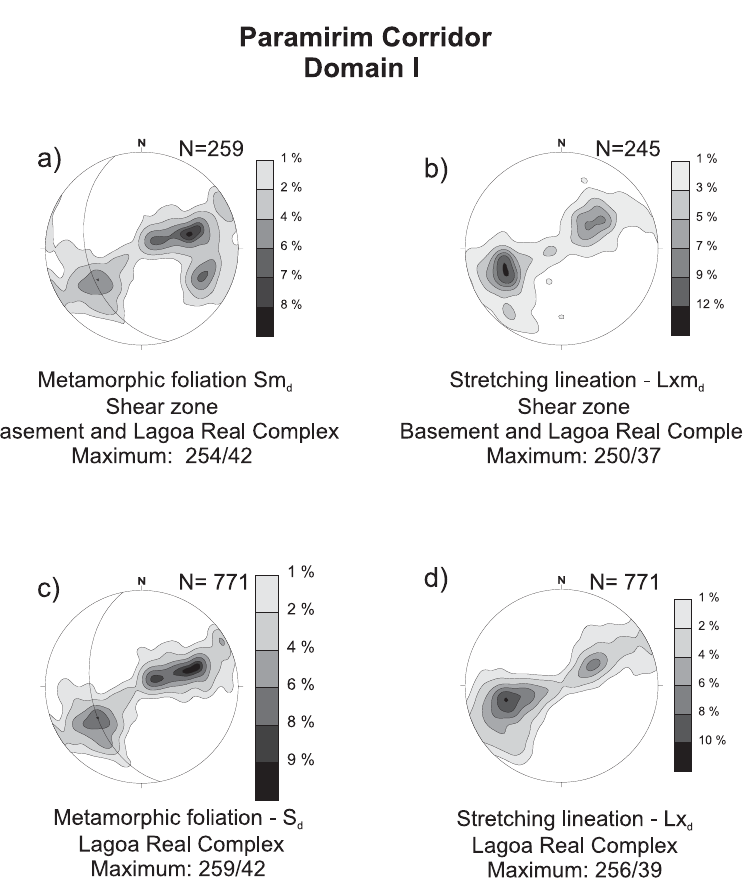
Fig. 6 – Equal-area, lower hemisphere stereonetplots of poles to foliations and lineations of basement and Lagoa Real Complex in structural domain